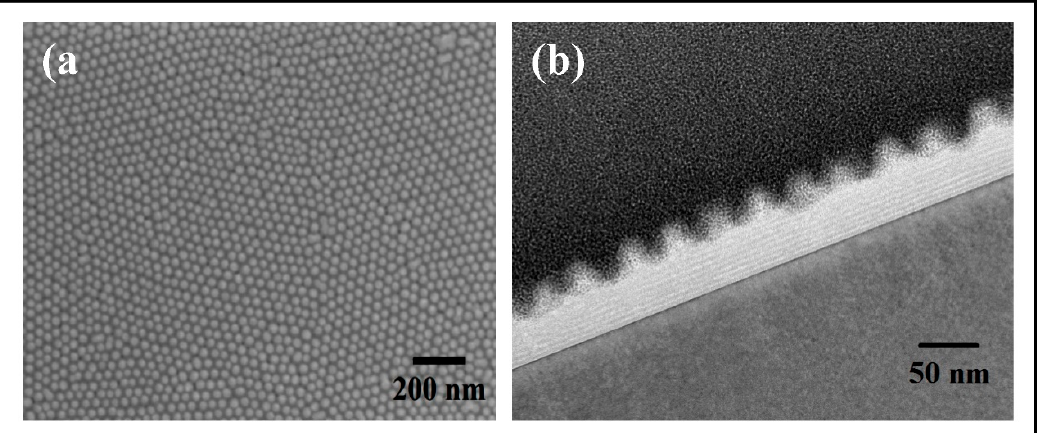
Figure 7. ( a ) Top-down SEM image of nanopillar arrays with iron oxide nanodots at the top formed after pattern transfer onto silica for 10 s ( b ) cross-sectional TEM image of the mesoporous silica nanopillars.